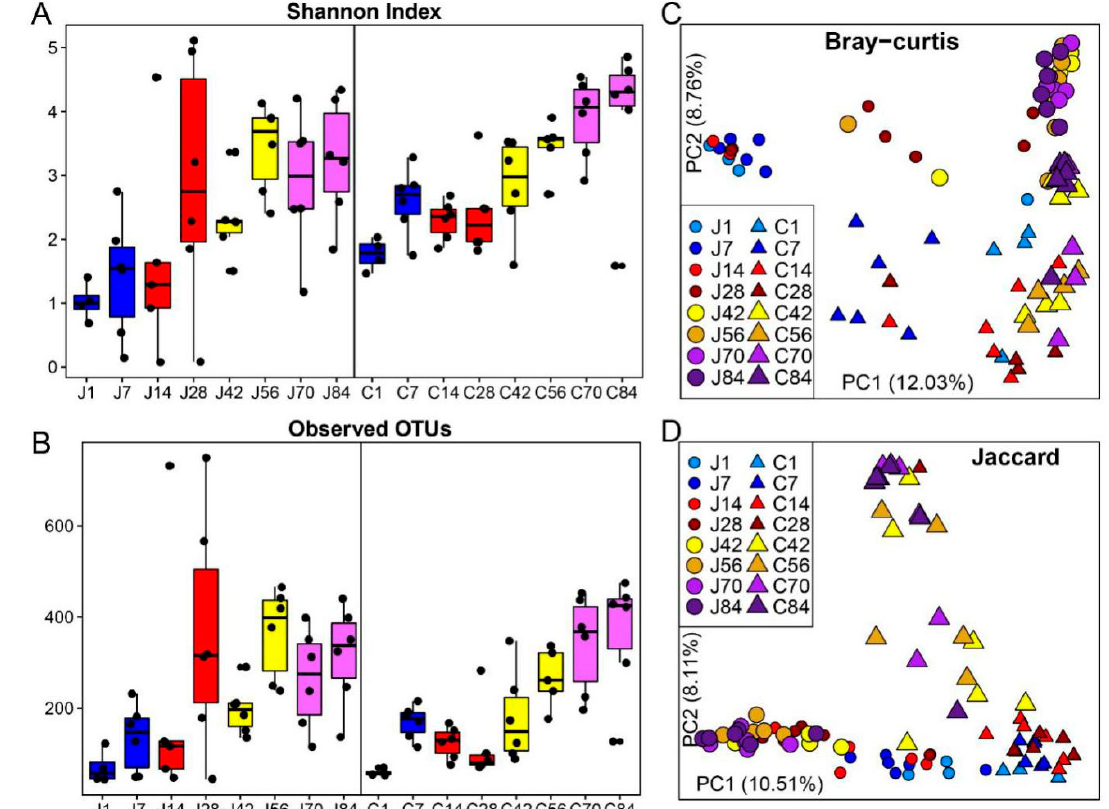
Figure 2. Microbial diversities and structure of the jejunum and colon at different ages in goat kids. ( A , B ): Longitudinal changes in the gut microbial community based on the Shannon Index and observed operational taxonomic units (OTUs). ( C , D ): The principal coordinate analysis (PCoA) based on the Bray–Curtis and Jaccard distances. Each point in ( A ) and ( B ) represents a unique sample. The growth phases of colostrum (d1 and d7), breast milk (d14 and d28), mixed feeding (d42 and d56) and starter feeding stages (d70 and d84) were differentiated by color (blue, red, yellow, and purple). Circles represent colon samples and triangles represent jejunum samples. J1 = jejunum d1; C1 = colon d1; the rest can be deduced by analogy.